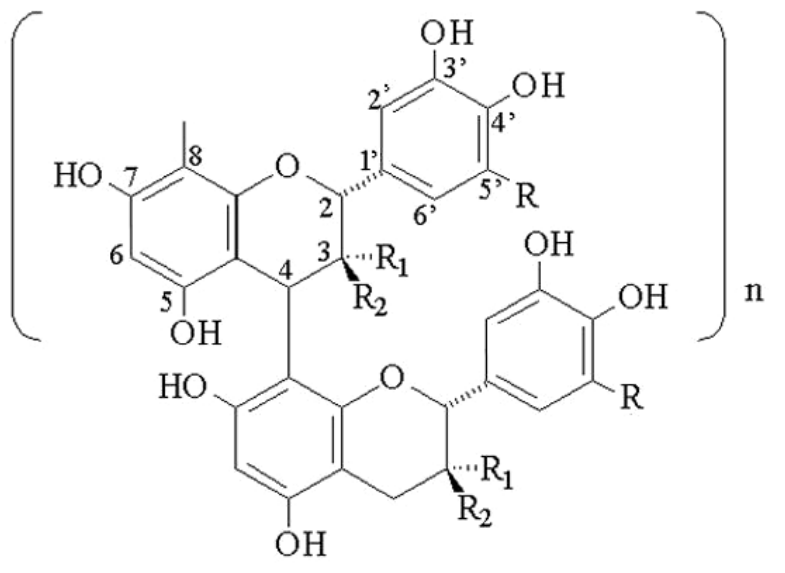
Figure 1. Chemical structure of proanthocyanidins. Where R = H, it is a